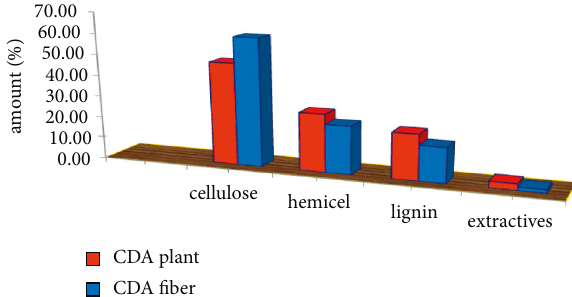
Figure 6: Chemical composition of CDA plant before and after extraction of the fiber. Table 5: Comparison of chemical composition of CDAF [45, 60, 73, 74].